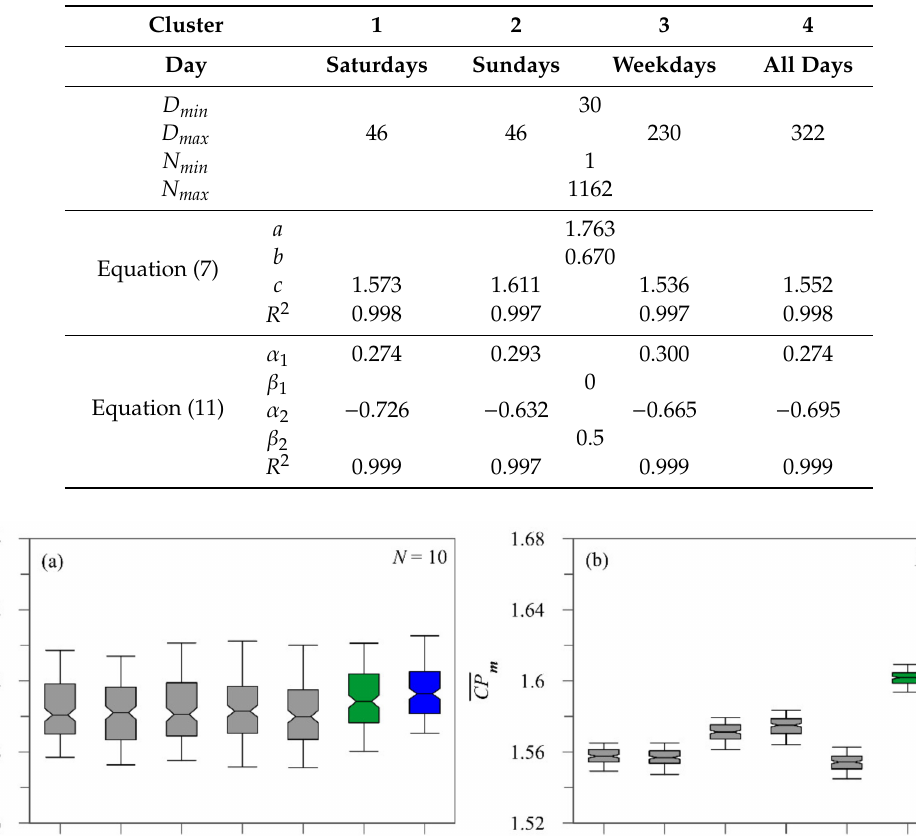
Table 1. Cluster definition and relevant parameters.